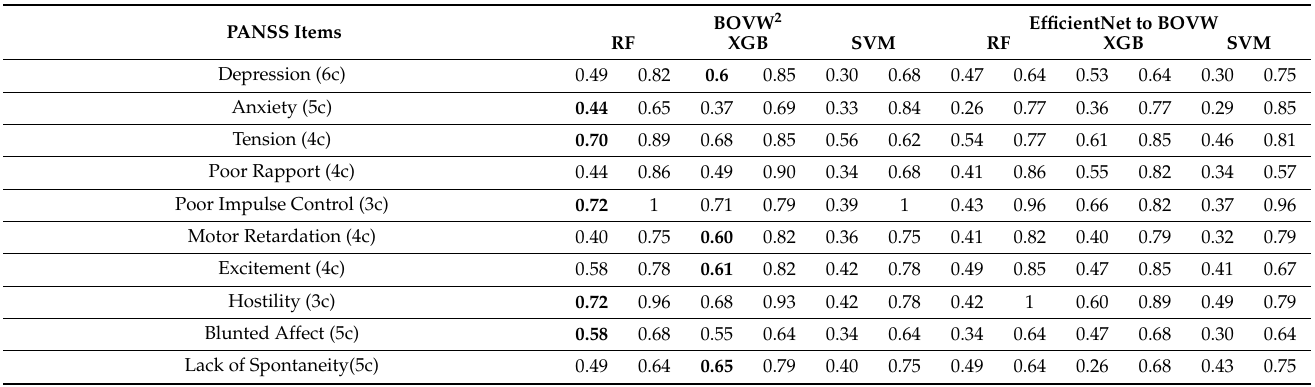
Table 20. Classification results for BOVW 2 (left) and EfficientNet to BOVW (right) configurations based on balanced accuracy (left) and top-2 accuracy (right) metrics. The number of respective classes is shown next to PANSS items.